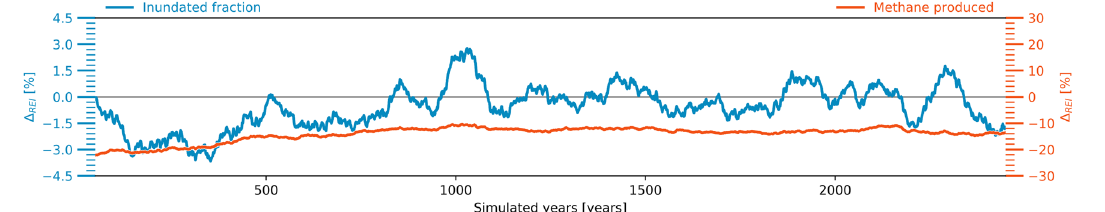
Fig. 8 Long-term effects of an temperature overshoot on wetland formation and soil methane production. Differences between simulations initialized with the soil carbon concentrations after (P2100) and before (NoOS) an temperature overshoot that persist under nontransient atmospheric conditions (PACT1.5). Shown are relative differences in annual mean inundated area (blue line, left y -axis) as well as relative differences in the soil methane production (red line, right y